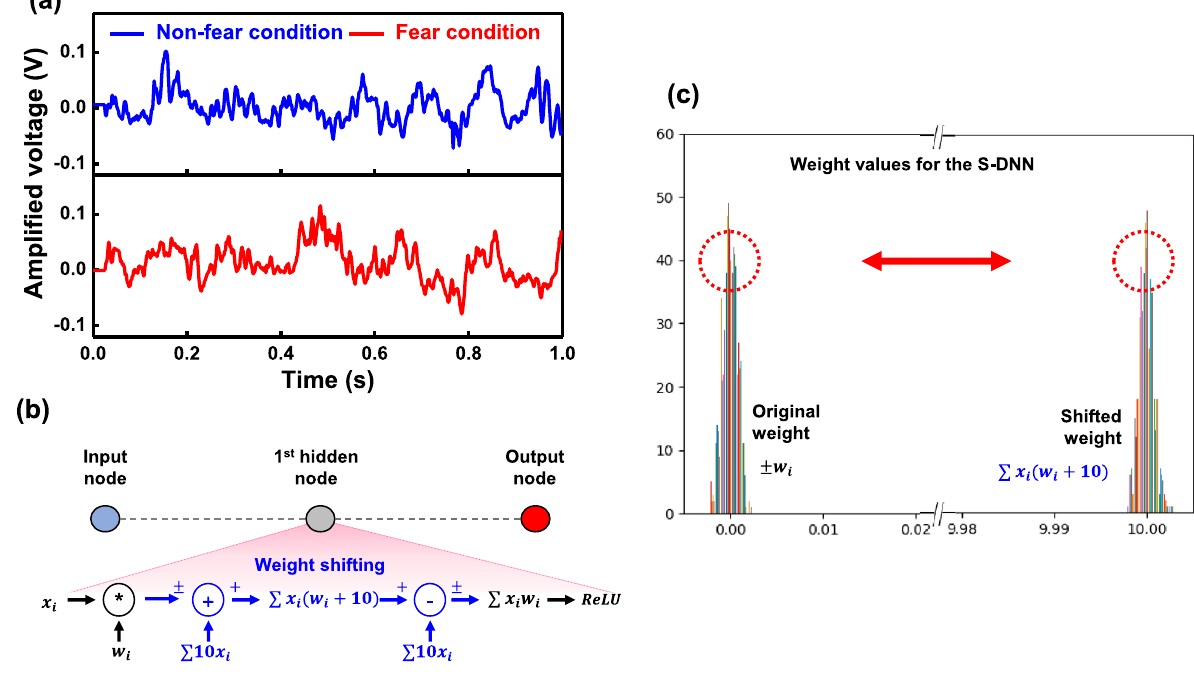
Figure 3. ( a ) Part of rat’s neural signals in non-fear and fear conditions. ( b ) Sequence of the weight shifter in S-DNN. Firstly, the weight values are positively shifted; then it returns back to origin before the ReLU function. ( c ) Weight values utilized in the S-DNN (original weights and shifted